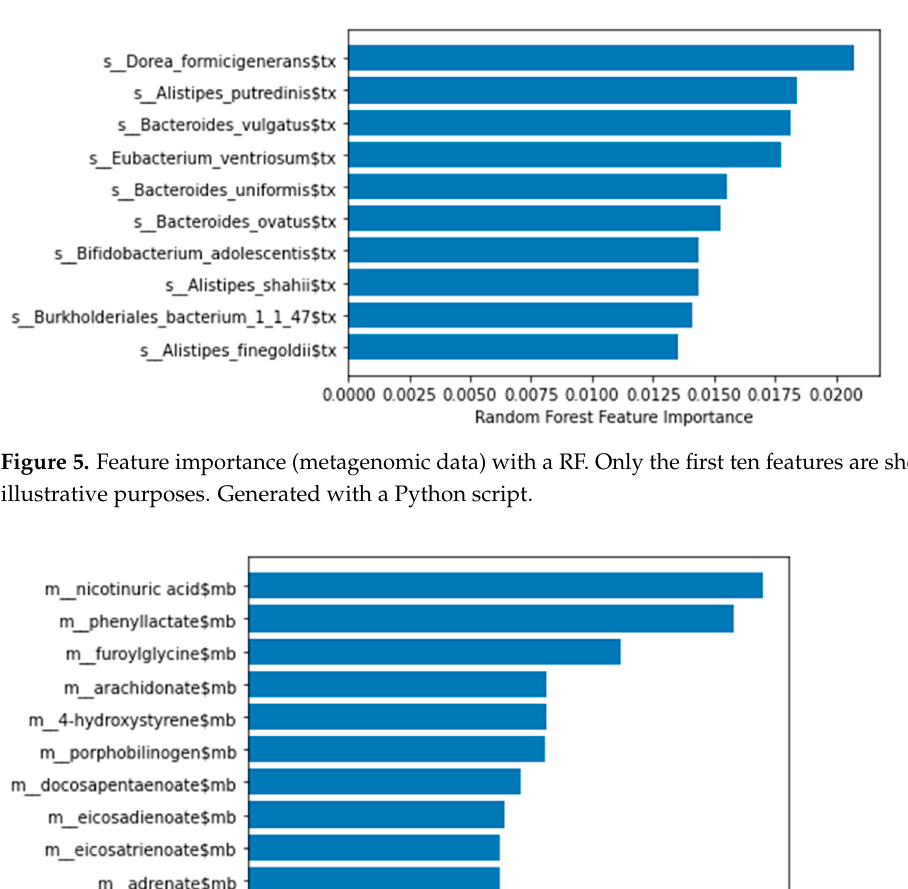
Figure 8. DBN for patients with UC with ‘restriction matrix’ constraints in the top-50 best features per omic type. Colours and shapes are as in Figure 7.